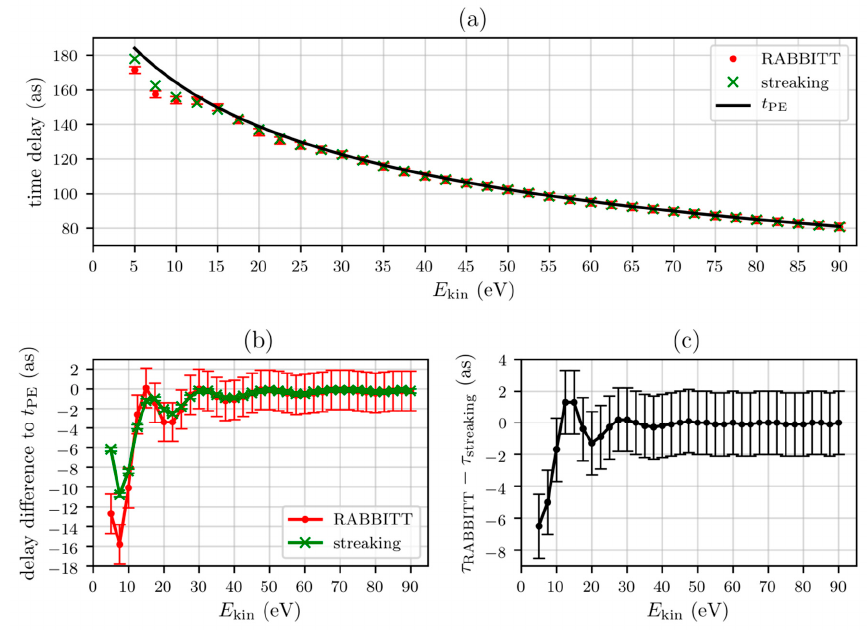
Figure 5. Comparison of streaking and RABBITT delays with classical photoemission transport times t PE . ( a ) Variation of streaking (green crosses) and RABBITT delays (red dots), as well as classical photoemission times (black) as a function of (vacuum) kinetic energy. For the streaking data, error bars are not shown because they are smaller than the symbol size. Streaking and RABBITT delays were extracted from spectrograms, calculated by solving the one-dimensional time-dependent Schrödinger equation (TDSE) (Equation (6)) for potential properties described in the main text. (b) Difference between RABBITT and streaking delays and classical photoemission times. (c) Difference between RABBITT and streaking delays.